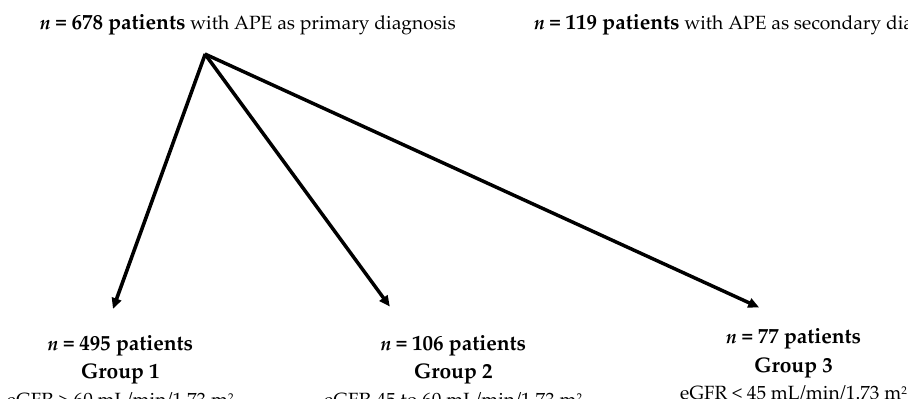
Figure 1. Flow chart. n :